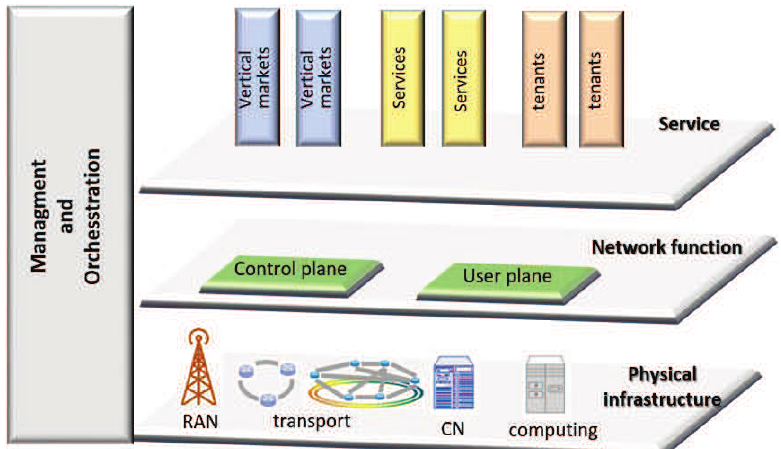
Figure 2. Network slicing conceptual